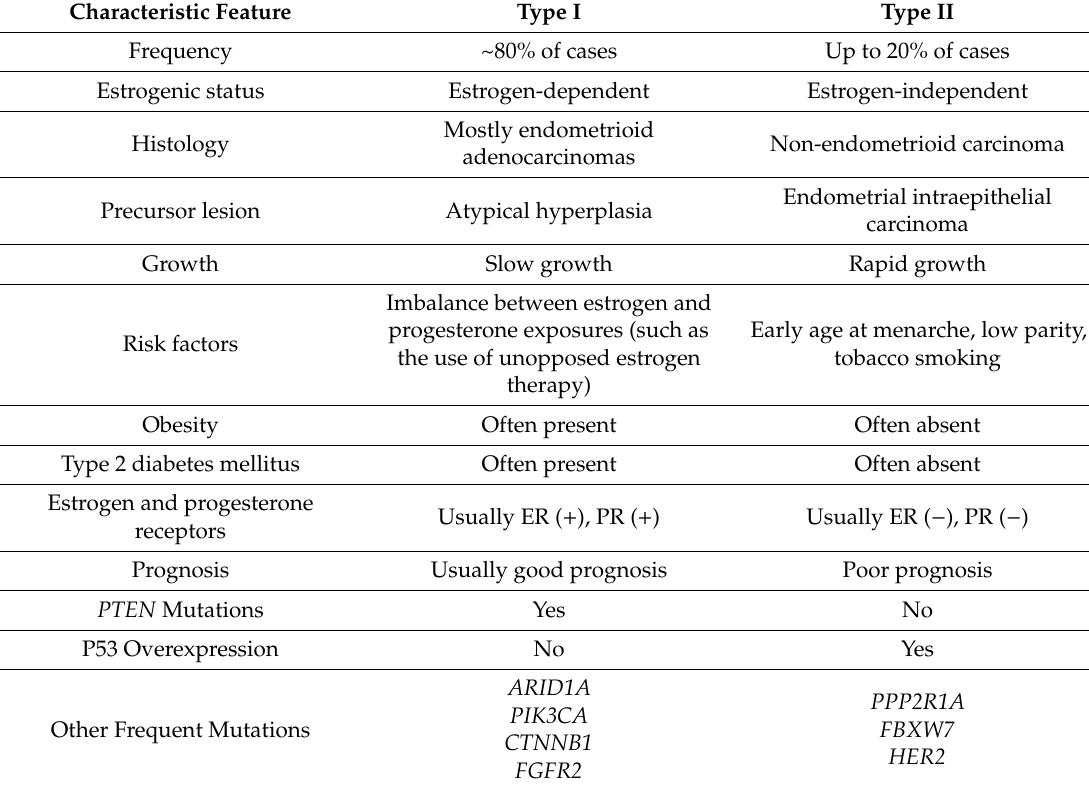
Table 1. Conventional comparison between type I and type II endometrial cancer